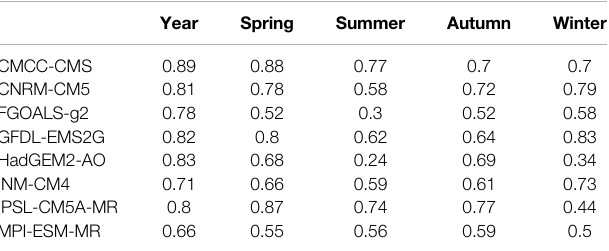
TABLE 4 | Correlation coef fi cients between zonal mean scaling exponents of NCEP and the model-simulated